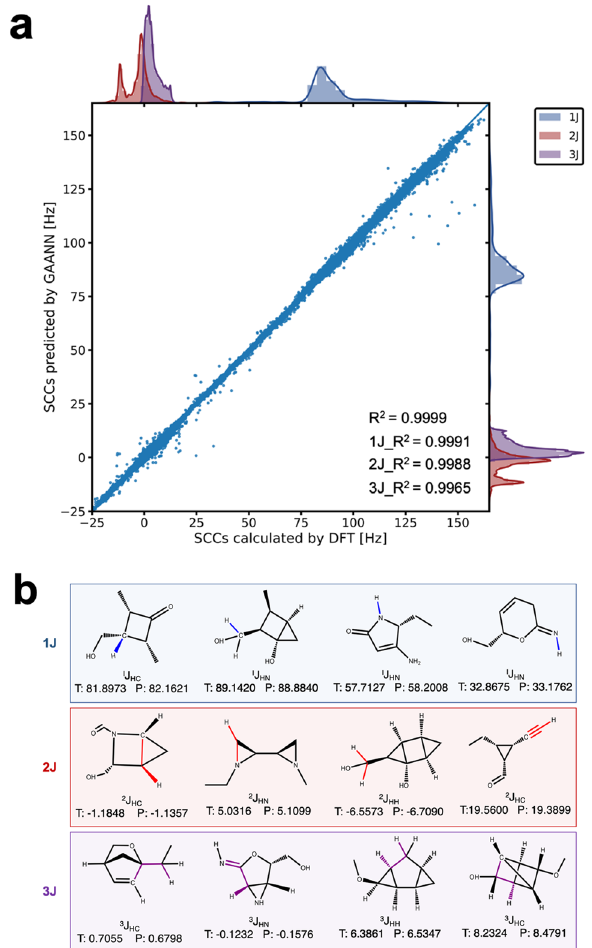
Figure 3. Evaluation of predicting performance of GAANN. ( a ) Plot of GAANN prediction versus DFT calculation. On the top and right of the figure, there are the kernel density curves of DFT goal values and prediction values respectively. Most of the scatter points are concentrated near the diagonal. ( b ) Twelve instances of DFT calculation (T) versus GAANN prediction (P). GAANN achieves satisfactory accuracy on three coupling types generally, and the margin of error is usually in the tenth